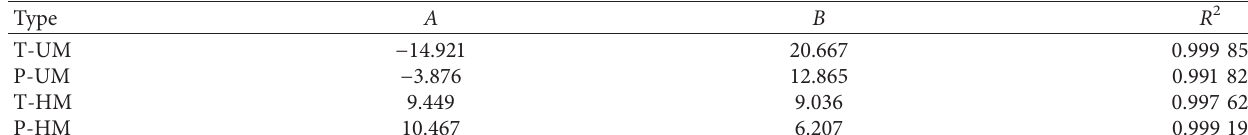
Table 6: Fitting results by using the Newman